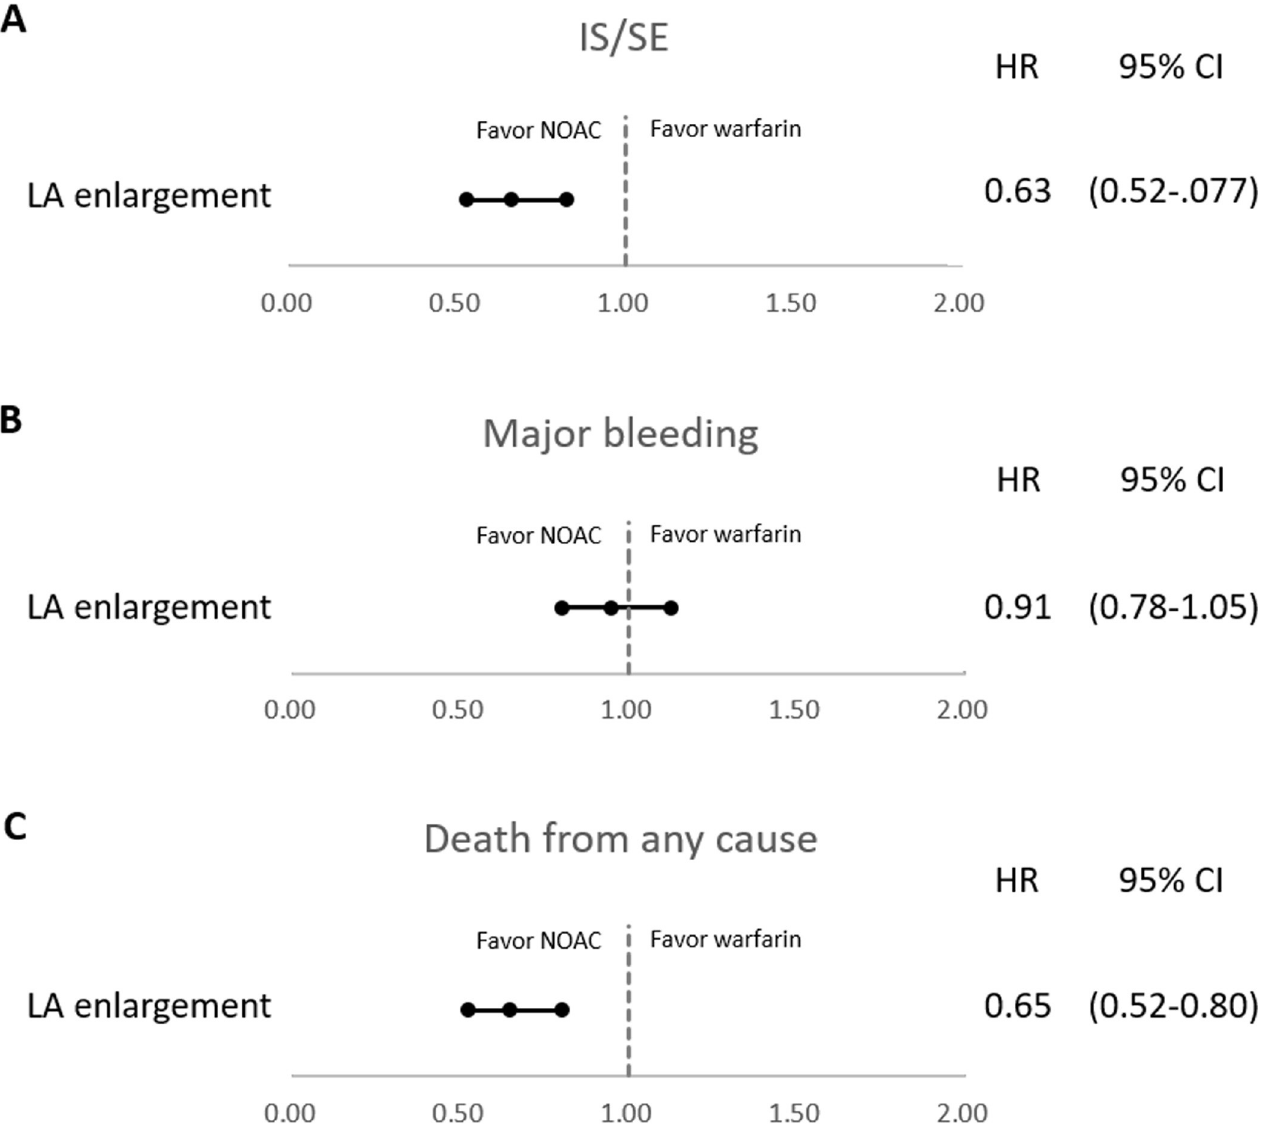
Fig 2. Primary outcomes that occurred during follow-up. (A) IS/SE, (B) major bleeding, (C) death from any cause. CI, confidence interval; HR, hazard ratio; IS/SE, ischemic stroke/systemic